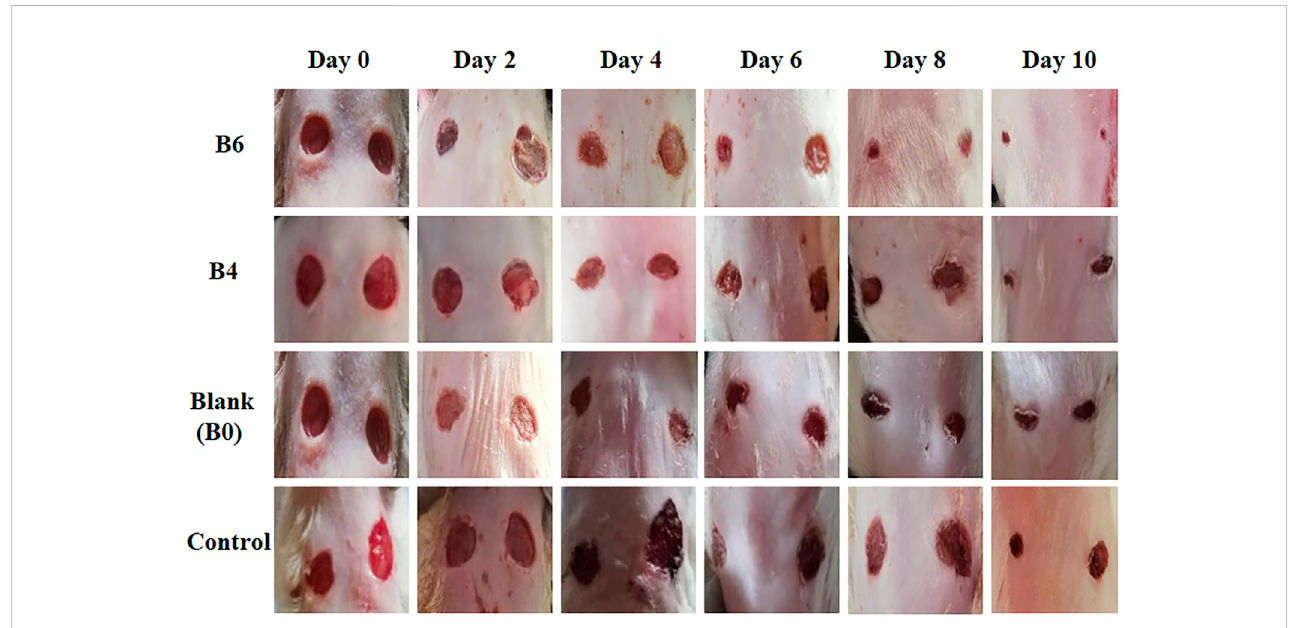
FIGURE 7 Macroscopic view of wound size reduction in various groups on different days i.e., group treated with extract-loaded fi lms (B6 and B4), blank fi lm (B0), and control (n = 4).